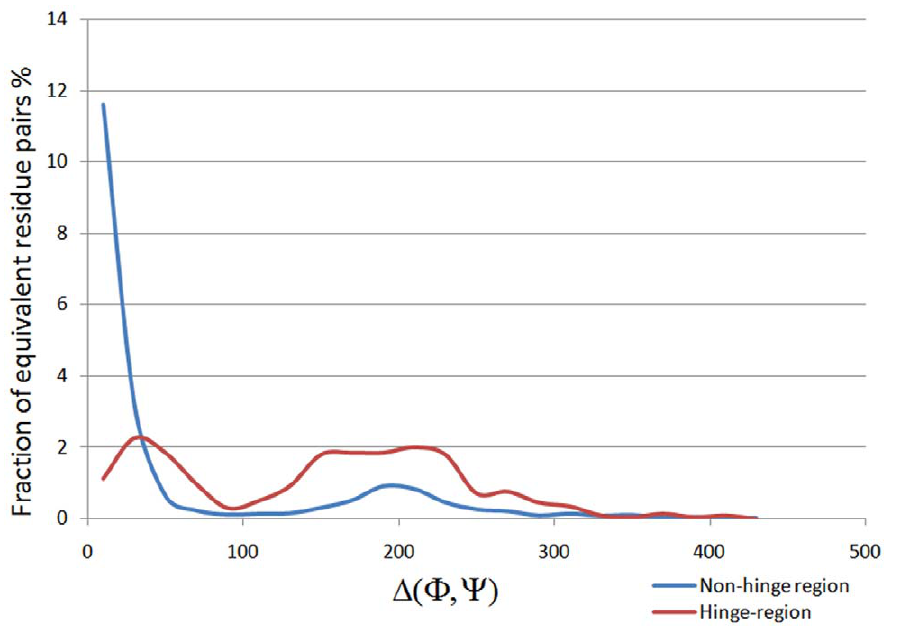
Figure 8. Distribution of D ( W , Y ) values of non-hinge residues and hinge-residues from domain-swapped protomers and their respective non-domain-swapped proteins.